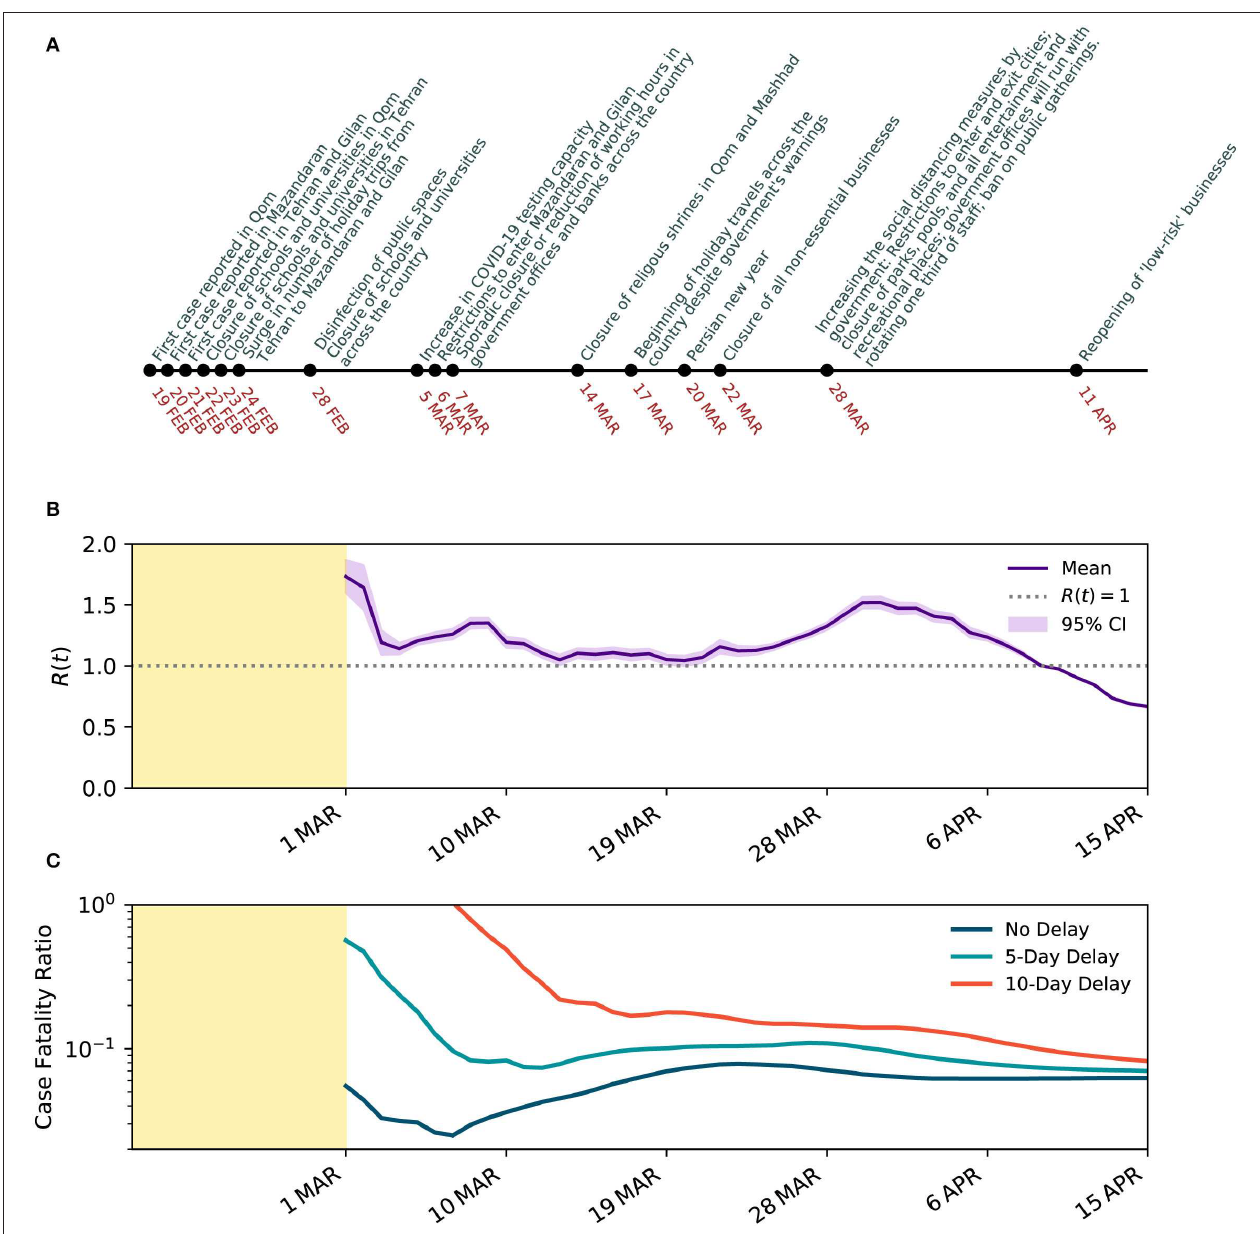
FIGURE 3 | Temporal evolution of SARS-CoV-2 transmission characteristics in Iran. (A) Timeline of events and interventions that took place since the first case was reported on 19 February 2020. (B) Estimated effective reproduction number R ( t ) with 95% CI over a 7-day rolling window when underreporting is taken into account. (C) Estimated CFR with and without delay adjustment over the same time period in a semi-log scale.